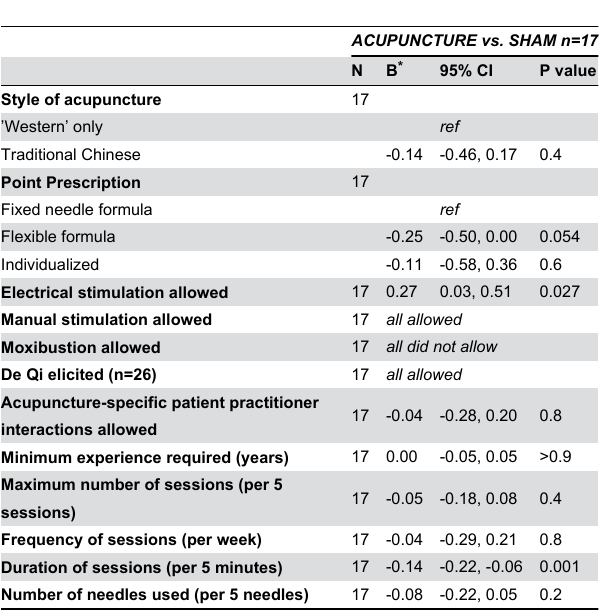
Table 4. Results of meta-regression for acupuncture trials with sham controls, excluding outlying trials.